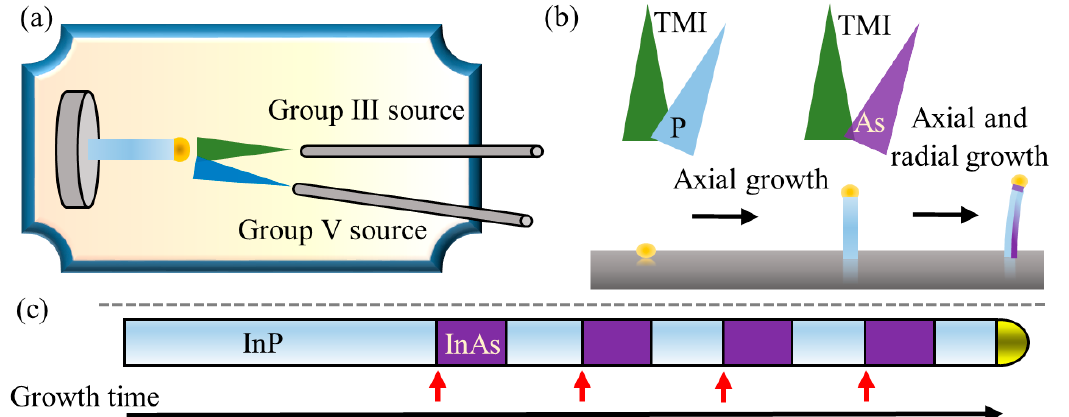
Figure 1. ( a ) Schematic of the metal–organic molecular beam epitaxy (MOMBE) growth chamber showing the vertical tube used to introduce group-III growth species to the system and the 30° inclined tube used for group-V species. ( b ) Schematic of the growth procedure of InP/InAs nanowire (NW) heterostructures and the resulting bent NW. ( c ) Schematic of the growth sequence illustrating the nominal NW form, where InAs (red arrows) was introduced four times following the growth of an InP NW. Note that the actual NW shape is significantly different.